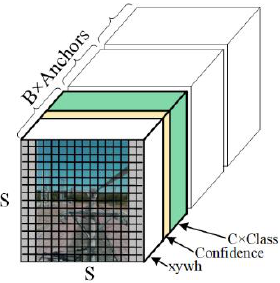
Figure 10. Output feature matrix of YOLOv5 head.